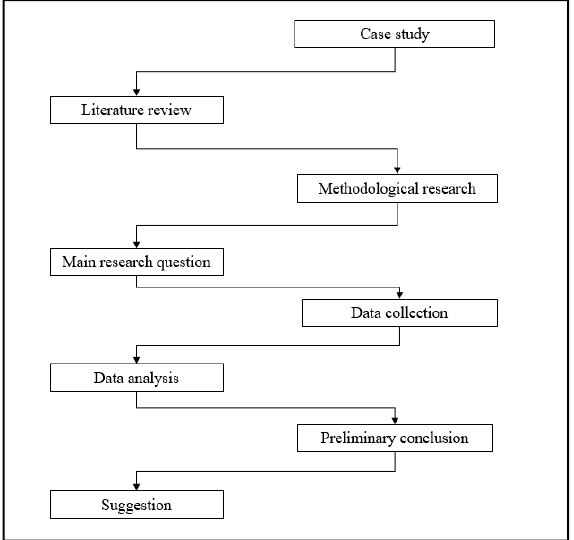
Figure 2. The conceptual research framework.